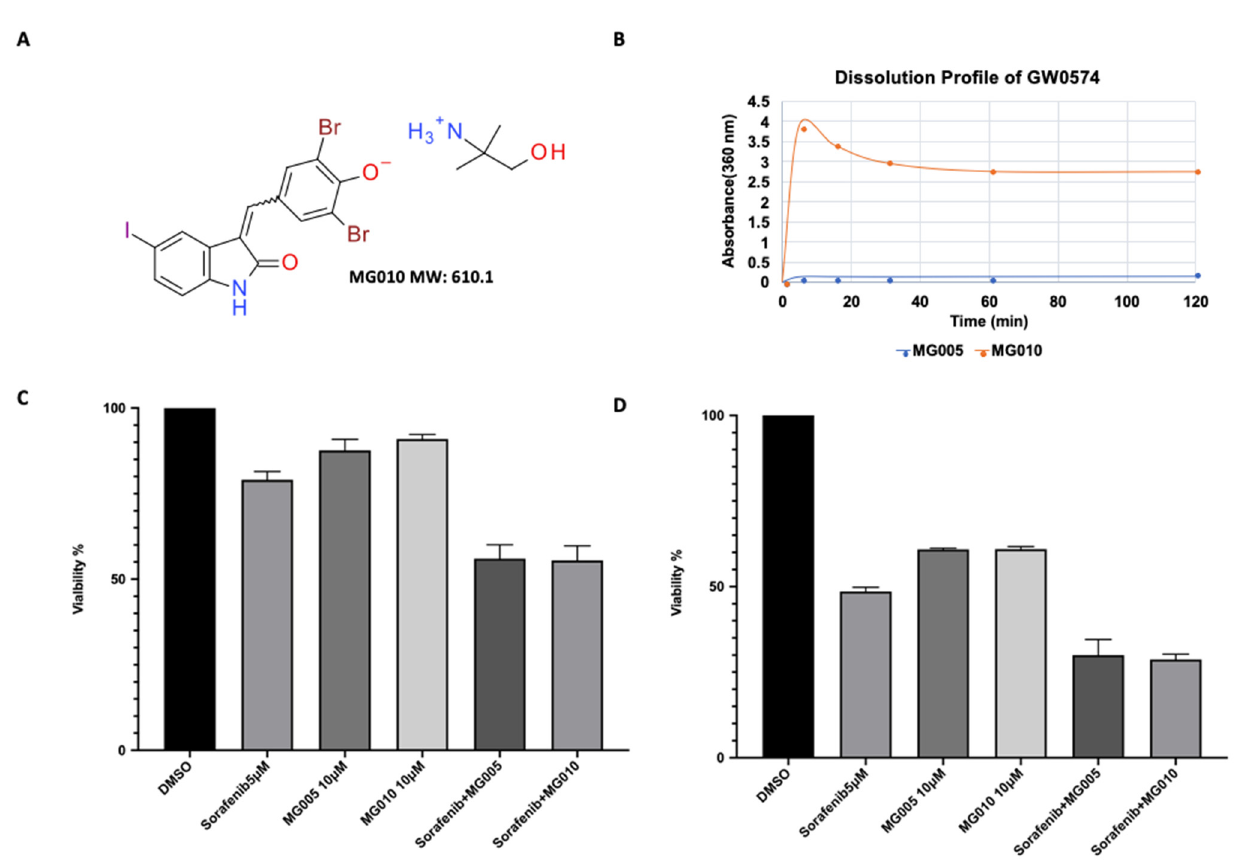
Figure 3. ( A ) Chemical structure of MG010. ( B ) Solubility of MG005 and MG010. ( C ) Viability test 24 h after ACHN treated with different drugs. ( D ) Viability test 48 h after ACHN treated with different drugs.